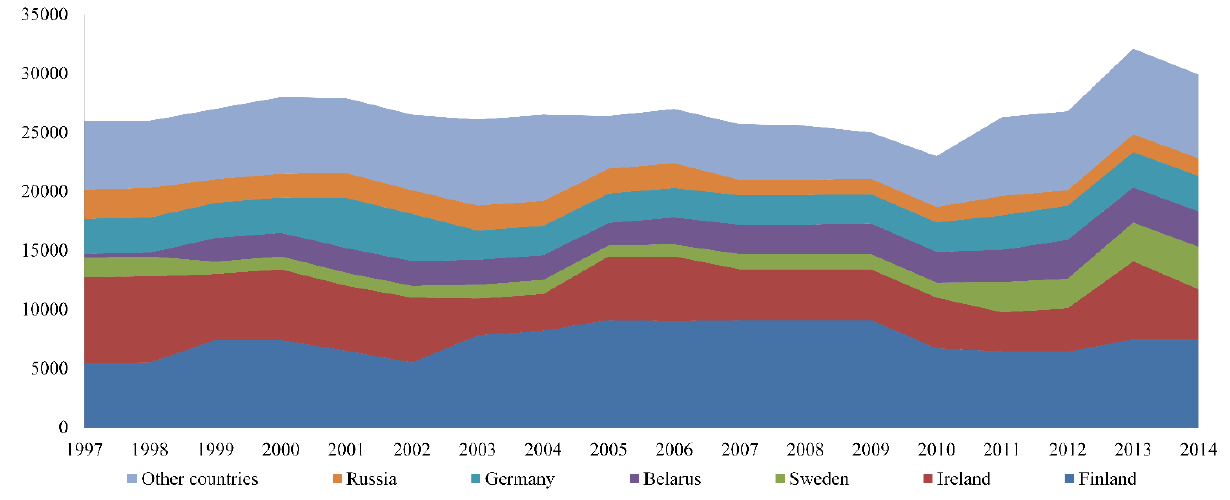
Figure 1. Global progress of peat extraction (units: thousand tonnes), 1997‒2014. Source: USGS